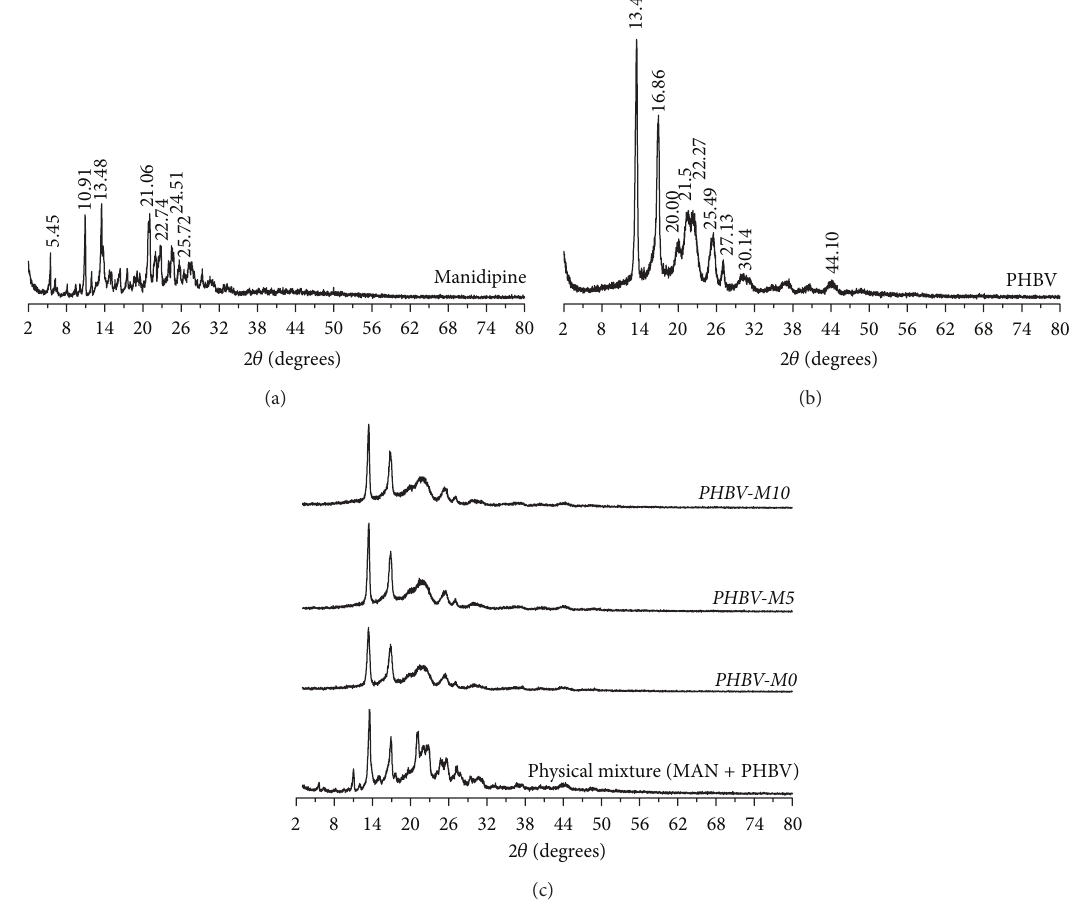
Figure 4: X-ray diffractions spectra of MAN, PHBV, physical mixture (MAN + PHBV), and PHBV microparticles.